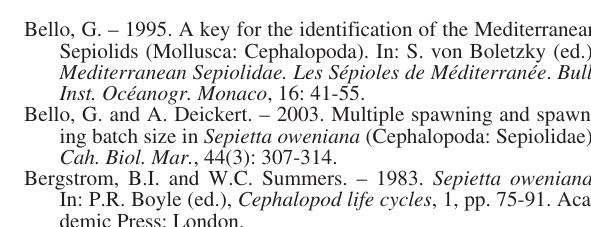
, mantle length at 50% sexual 50